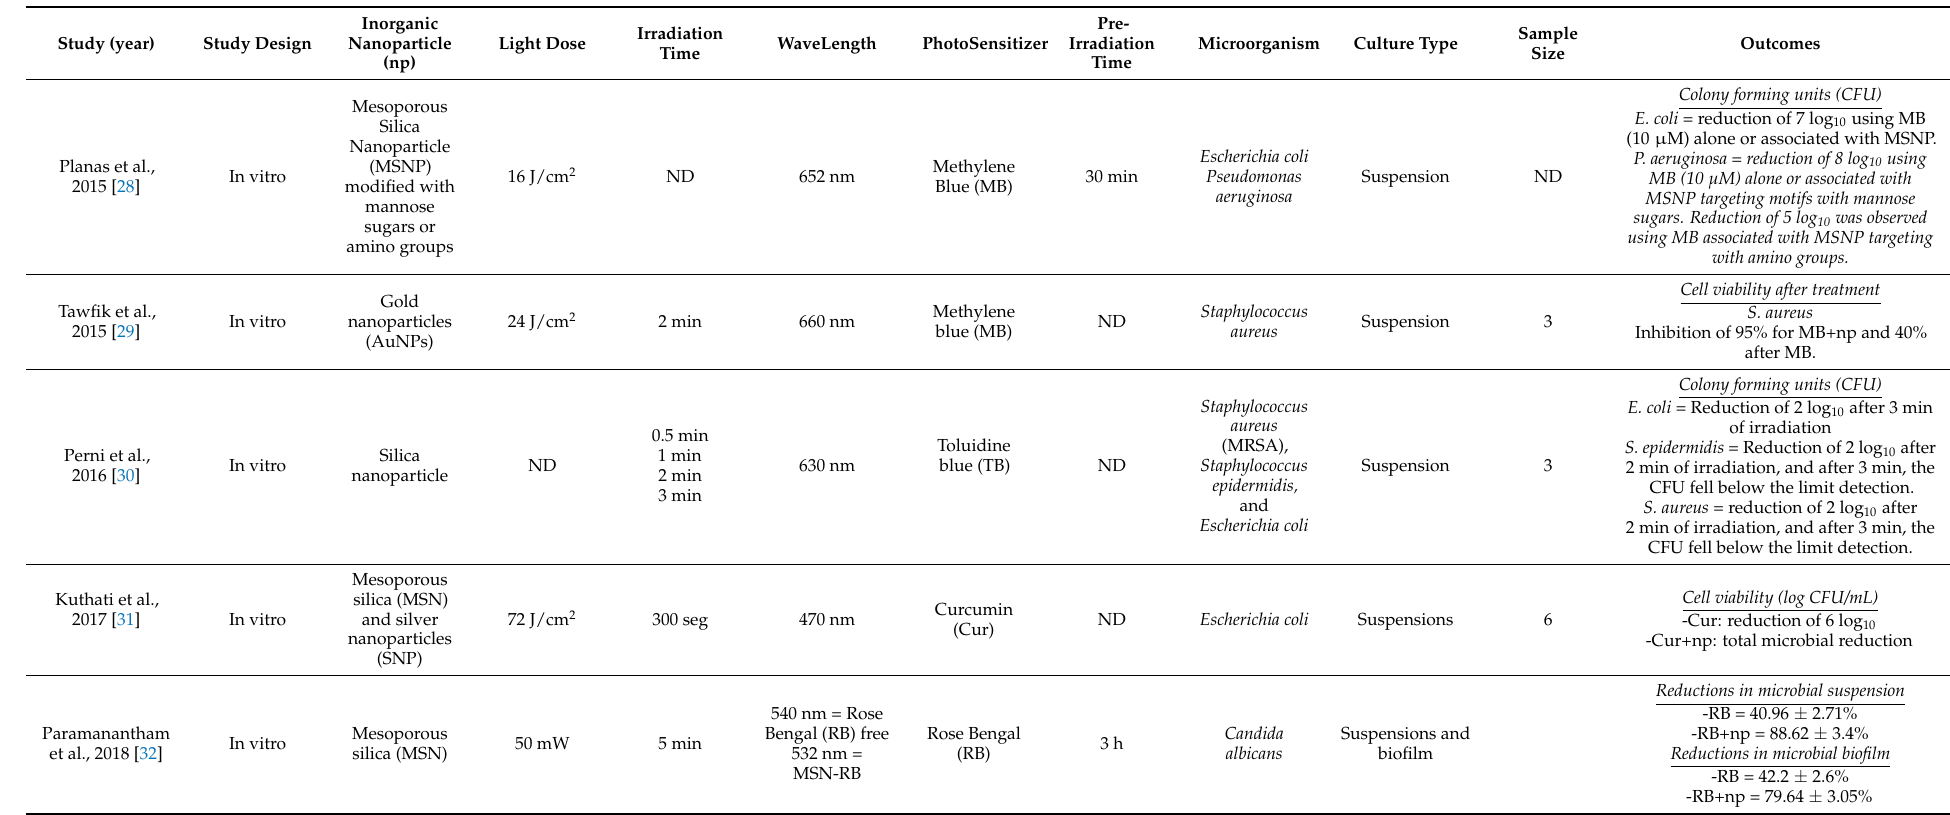
Table 1. Summary finds of data extraction from included